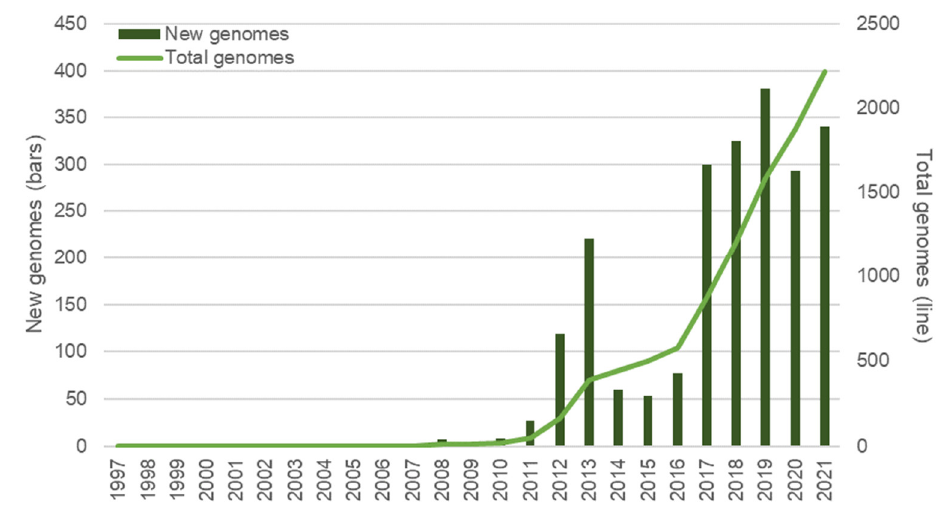
Figure 3. Overview of H. pylori genomes made available over time. Bars represent the new genomes released in each year; the total number of genomes available at each year is represented with a line. Data was retrieved from the PATRIC database [226] (last accessed in January 2022) and refer only to genomes submitted until the end of 2021; 34 genomes with no credible submission year were not taken into consideration for this graphic.